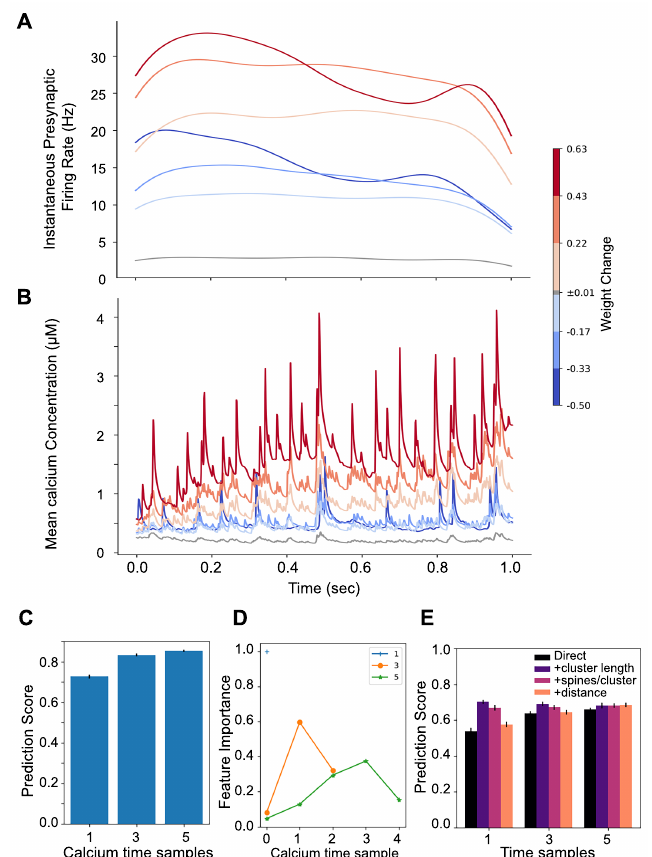
Figure 10. Simulations using spike trains with shuffled ISIs. Temporal pattern of pre-synaptic firing rate and calcium dynamics are different with shuffled spike trains, but still predict weight